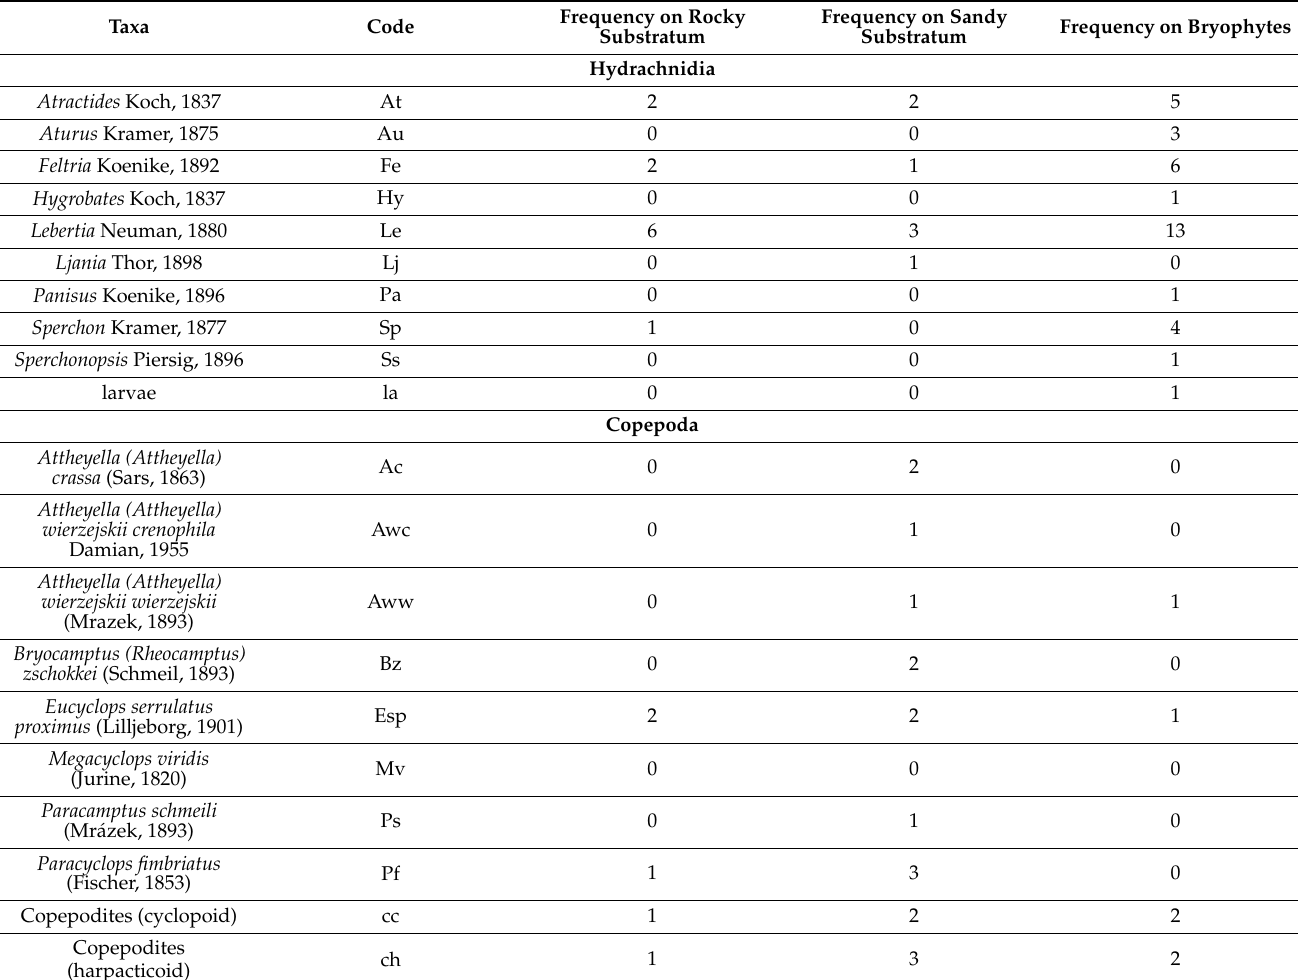
Table 2. List of water mite genera (Hydrachnidia) and copepod species (Crustacea, Copepoda: Cyclopoida and Harpacticoida) and their frequency of appearance on different substrata (number of